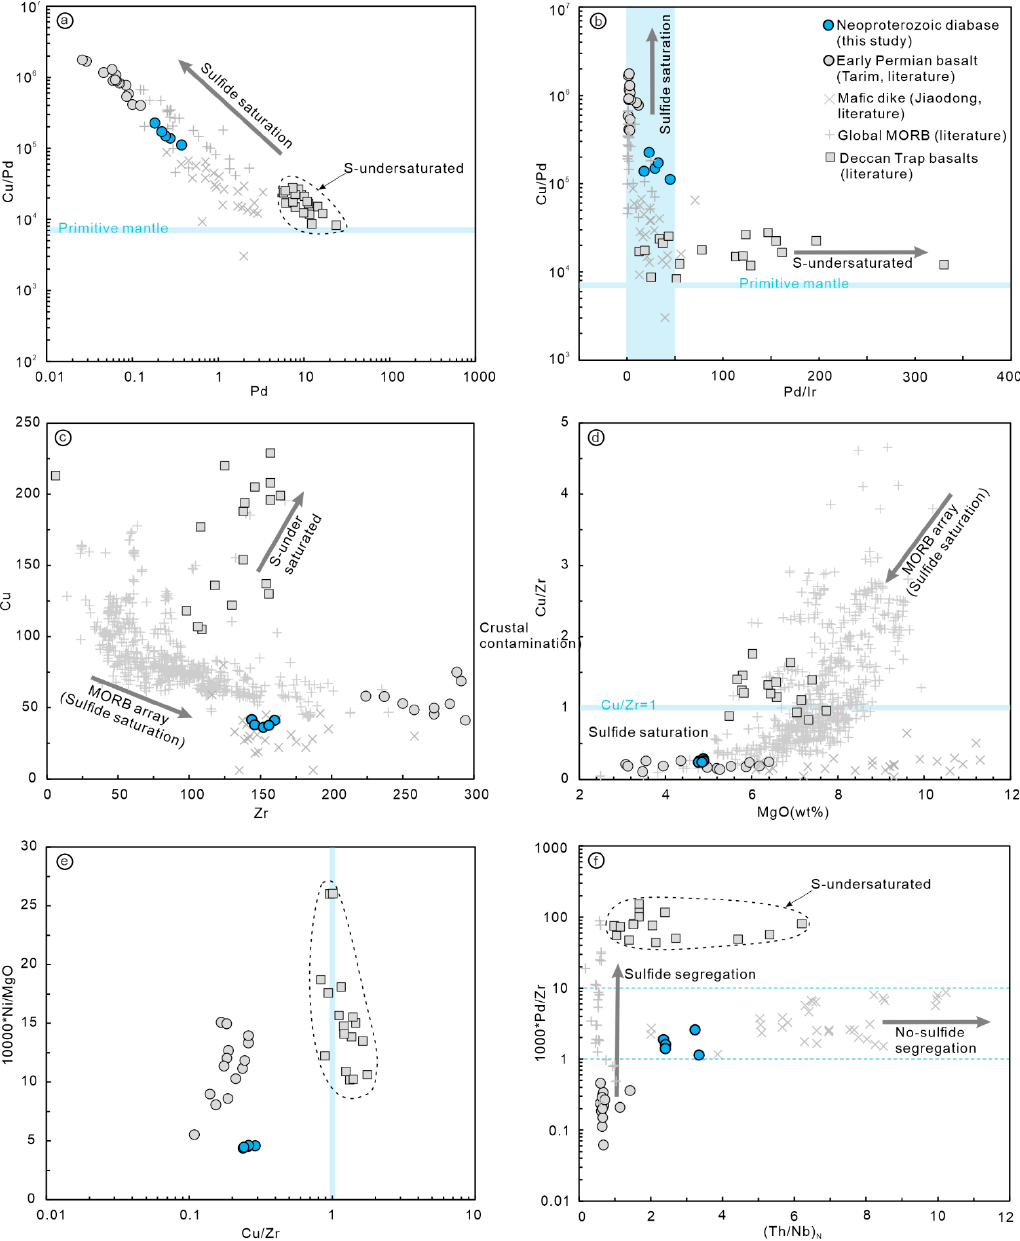
Figure 11. ( a ) Diagram showing variations in Cu/Pd ratios compared to Pd concentrations [85]. ( b ) Pd/Ir versus Cu/Pd diagram [88]. ( c ) Cu versus Zr diagram [89]. ( d ) Cu/Zr versus MgO diagram [89]. ( e ) Ni/MgO versus Cu/Zr diagram [87]. ( f ) Pd/Zr versus (Th/Nb) N diagram [87]. Data sources: Early Permian basalt [89], Jiaodong mafic dyke [5,81], Deccan Trap basalts [87], and Global MORB [82,83]. Literature data are compiled in Supplementary Table S2.